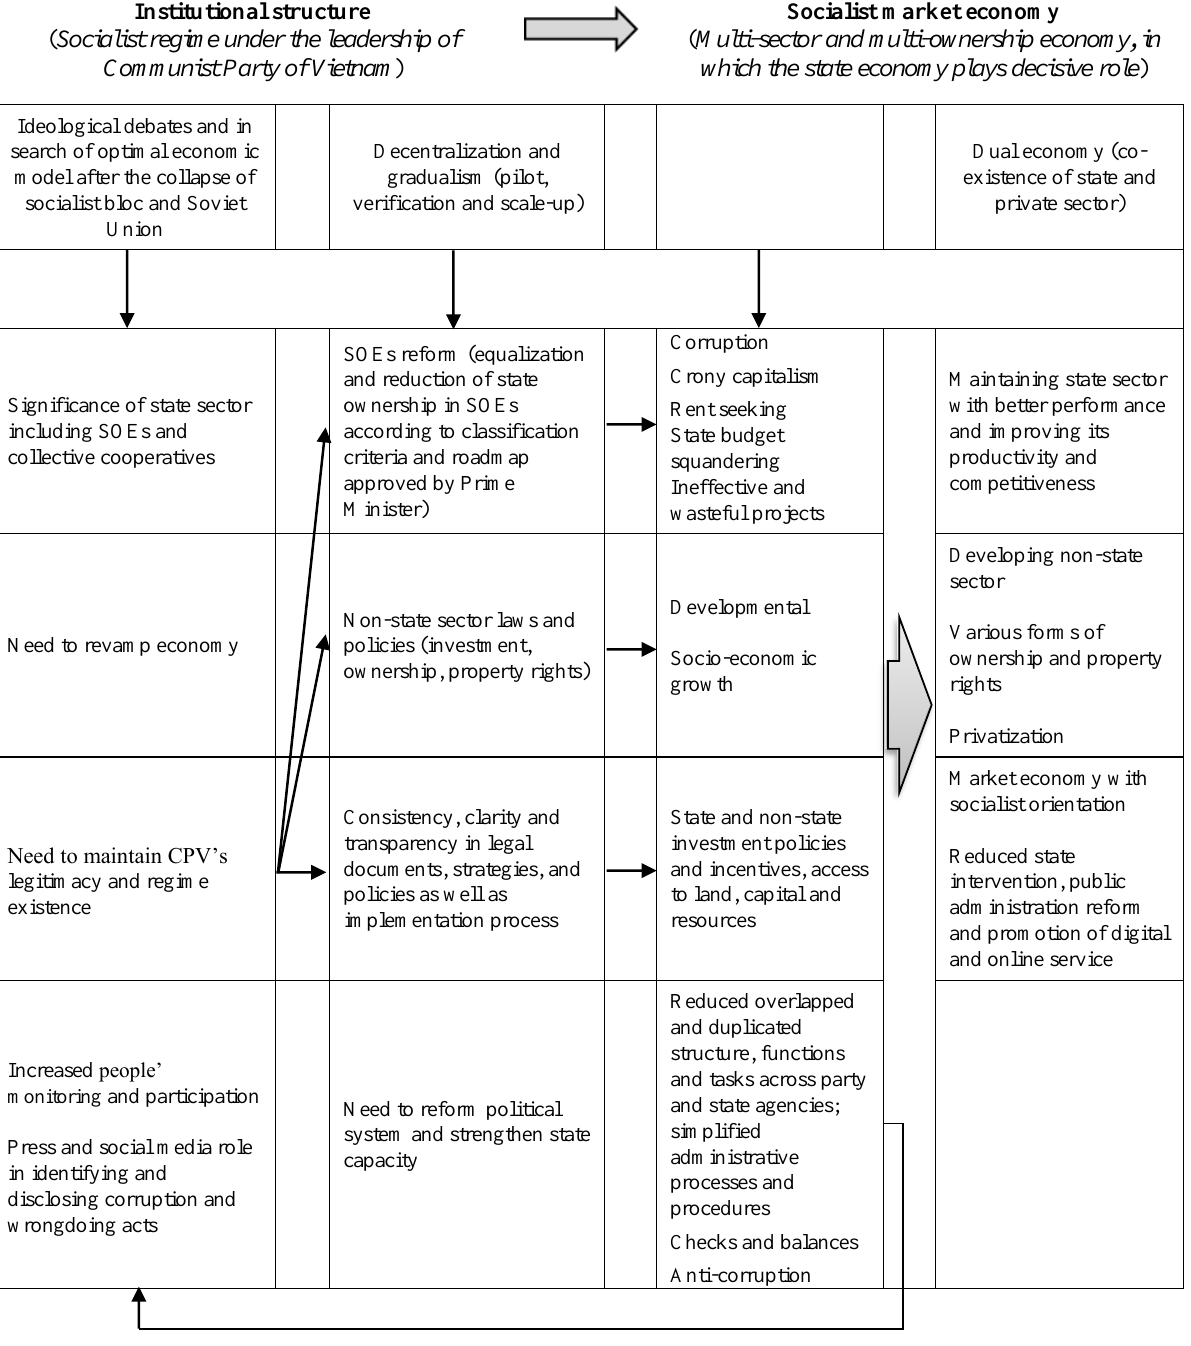
Figure 3. Adapted historical institutional model for